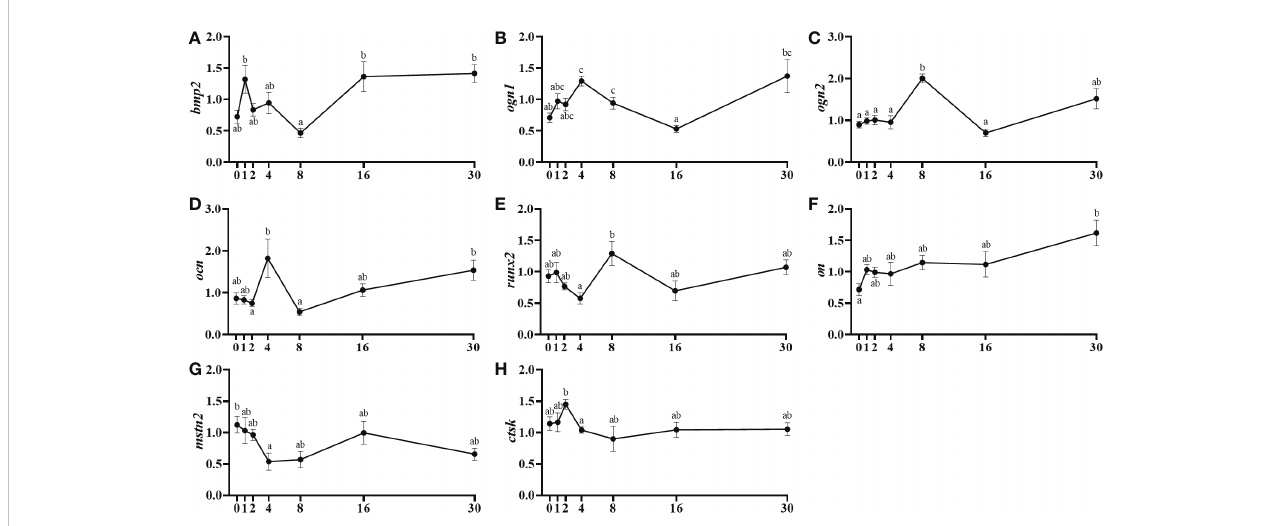
FIGURE 6 Relative gene expression of the bone markers, bmp2 (A) , ogn1 (B) , ogn2 (C) , ocn (D) , runx2 (E) , on (F) , mstn2 (G) , and ctsk (H) in the vertebra of injured of fi sh. Data are shown as means ± SEM, n=10. Statistical analysis was assessed by one-way ANOVA. Different letters indicate signi fi cant differences of factor time (days